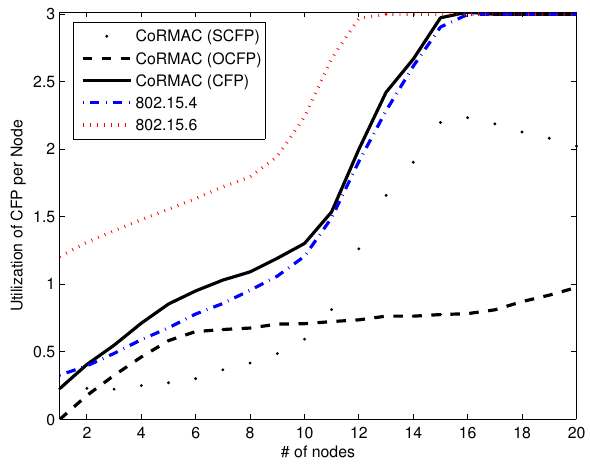
Figure 10. The utilization in CFP vs. the number of nodes.